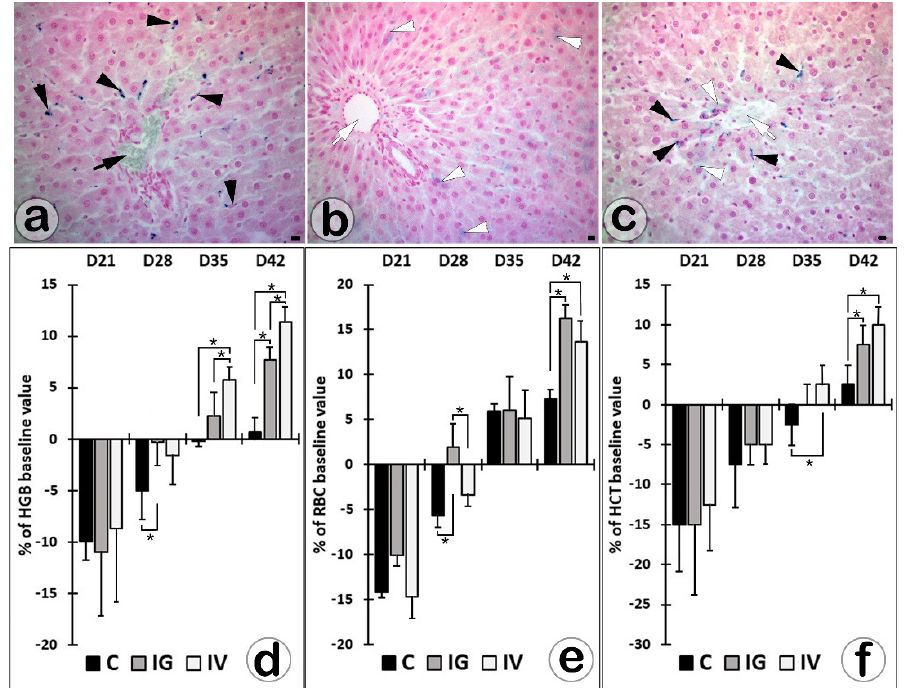
Figure 4. Kupffer cells (black arrowheads) and hepatocytes (white arrowheads) with intracytoplasmic SaIONP deposits in the portal (black arrows) and central (white arrows) spaces 7 days after IV ( a ) or IG ( b , c ) nanoparticles’ administration (Perls Prussian blue staining; Bar = 10 µm). Post-therapeutic values and time of return to baseline values for HGB ( d ), RBC ( e ), and HCT ( f ) in untreated (C) or IV/IG-treated rats with bleeding-induced anemia (* p < 0.05; one-way ANOVA with post-hoc Tukey test).